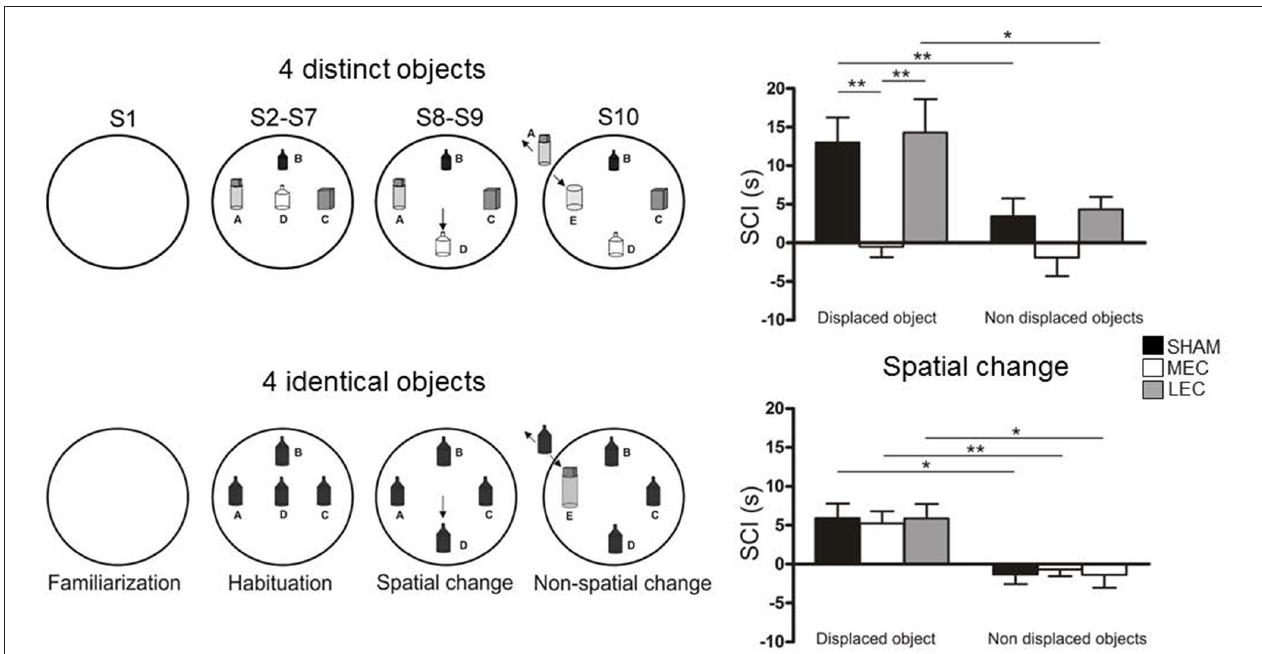
FIGURE 2 | Object exploration task used by Rodo et al. (2017). (A) The rats were submitted to 10 successive 4-min exploration sessions (S1-S10) in a circular arena containing four distinct or four identical objects (A–D present from S2 to S10). In both conditions, during S8 and S9, one object (B as indicated by the arrow) was moved to a new location (spatial change). During S10, one familiar object (A) was replaced by a novel object (E as indicated by the arrow). (B) The ability of rats to detect spatial novelty was measured using a spatial change index (SCI = duration of object exploration in S8-S7) calculated for the displaced object and the non-displaced objects. Positive bars indicate a re-exploration of the objects. SHAM and lateral entorhinal cortex (LEC) rats re-explored the displaced objects but not the non-displaced objects indicating preserved ability to process spatial information. In contrast the medial entorhinal cortex (MEC) rats did not re-explore either kind of object indicating that they were not able to process spatial information. LEC rats were impaired to identify the novel object (S10) in the four distinct object condition but objet recognition ability was restored in the four identical object condition (data not shown). MEC and SHAM rats were able to detect the novel object in the two conditions. ∗ p < 0.05, ∗∗ p <